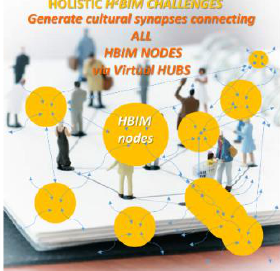
Figure 5. Holistic HBIM networking to generate cultural